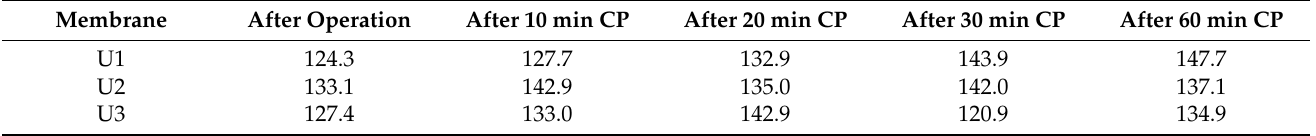
Figure 9. Topographical images of membranes after cleaning for different durations. Table 2. The RMS values (nm) calculated based on the topographic images of the membranes after filtration operation and chemical